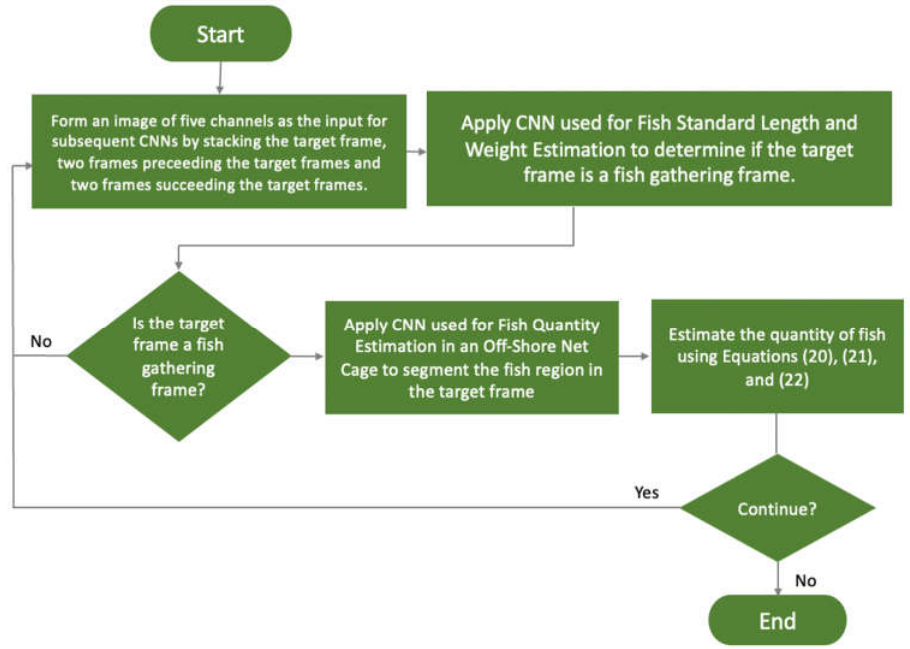
Figure 15. The flowchart of estimating the quantity of fish in an off-shore net cage.